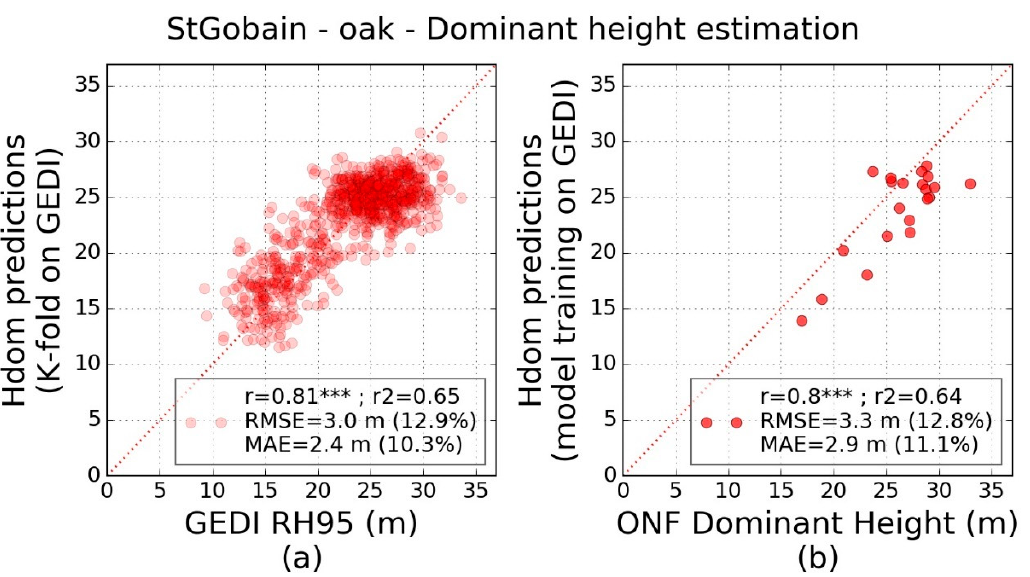
Figure 10. Oak samples (StGobain). Validation scatterplots of dominant height estimation using GEDI RH95% metric for the training model (808 samples). ( a ) GEDI’s K-fold cross-validation; ( b ) application of GEDI model on ONF measurement plots (21 samples). Statistical signicicance: *** p ≤ 0.001.